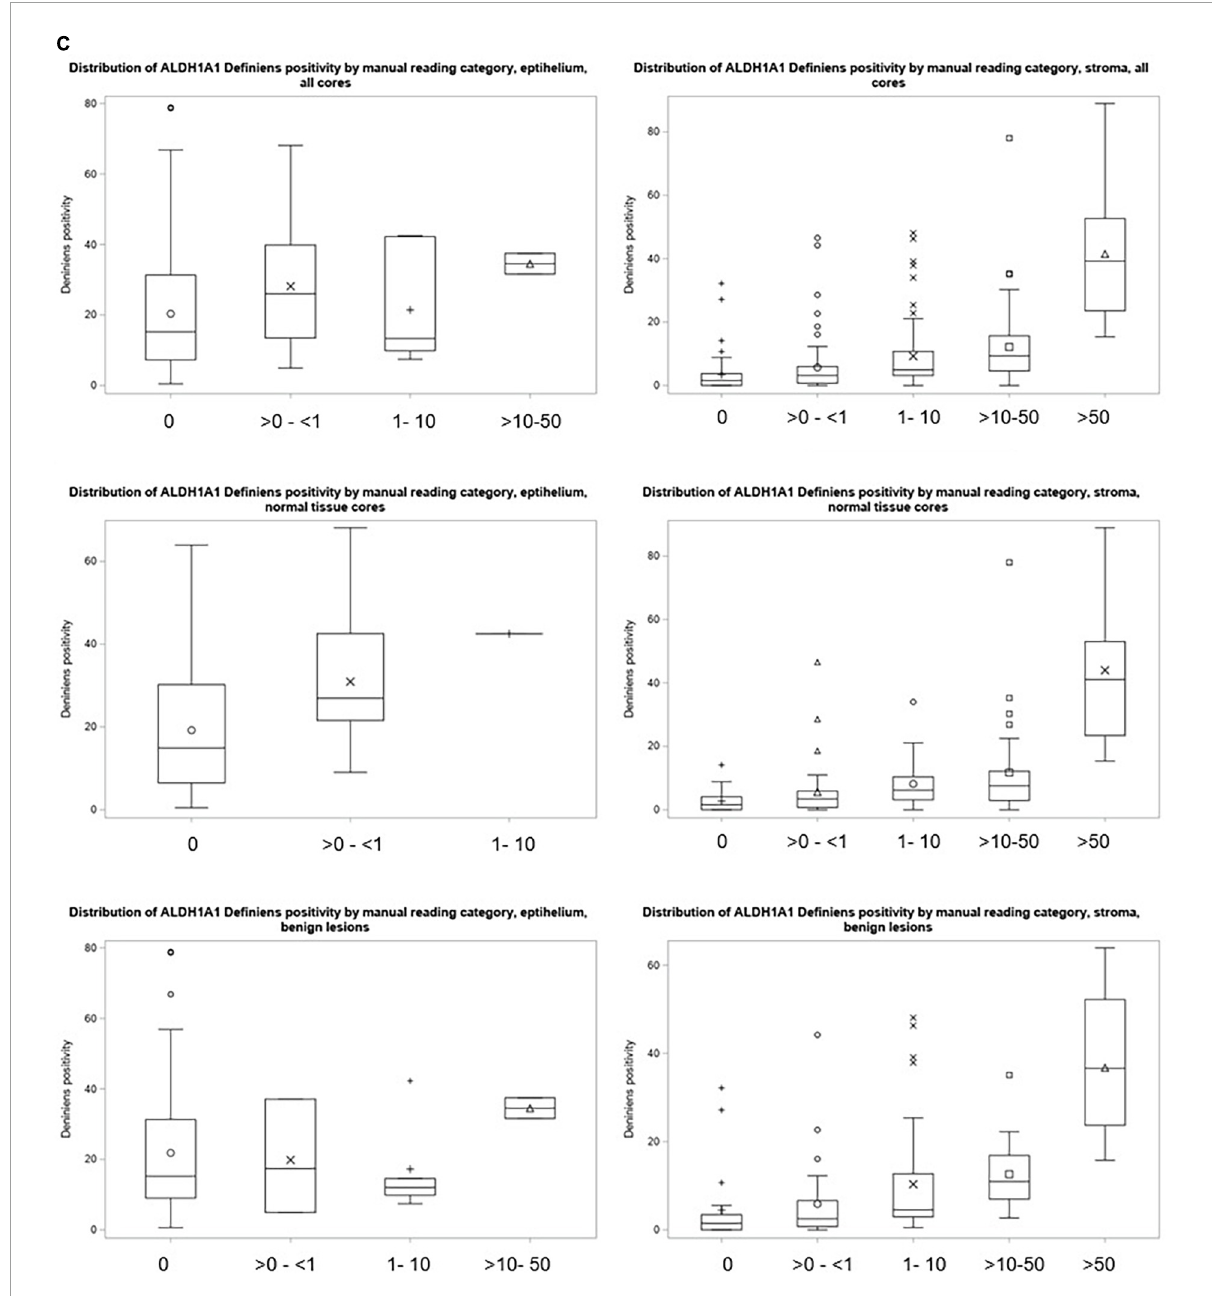
FIGURE4 (C) Distribution of ALDH1A1 Definiens positivity according to the manual reading